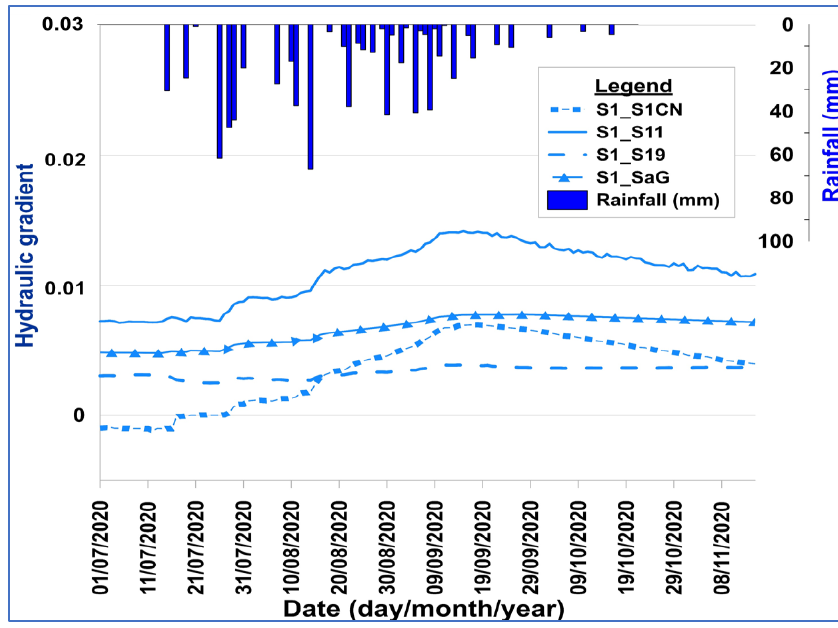
Figure 4. Temporal evolution of the hydraulic gradients of the Sanon aquifers.